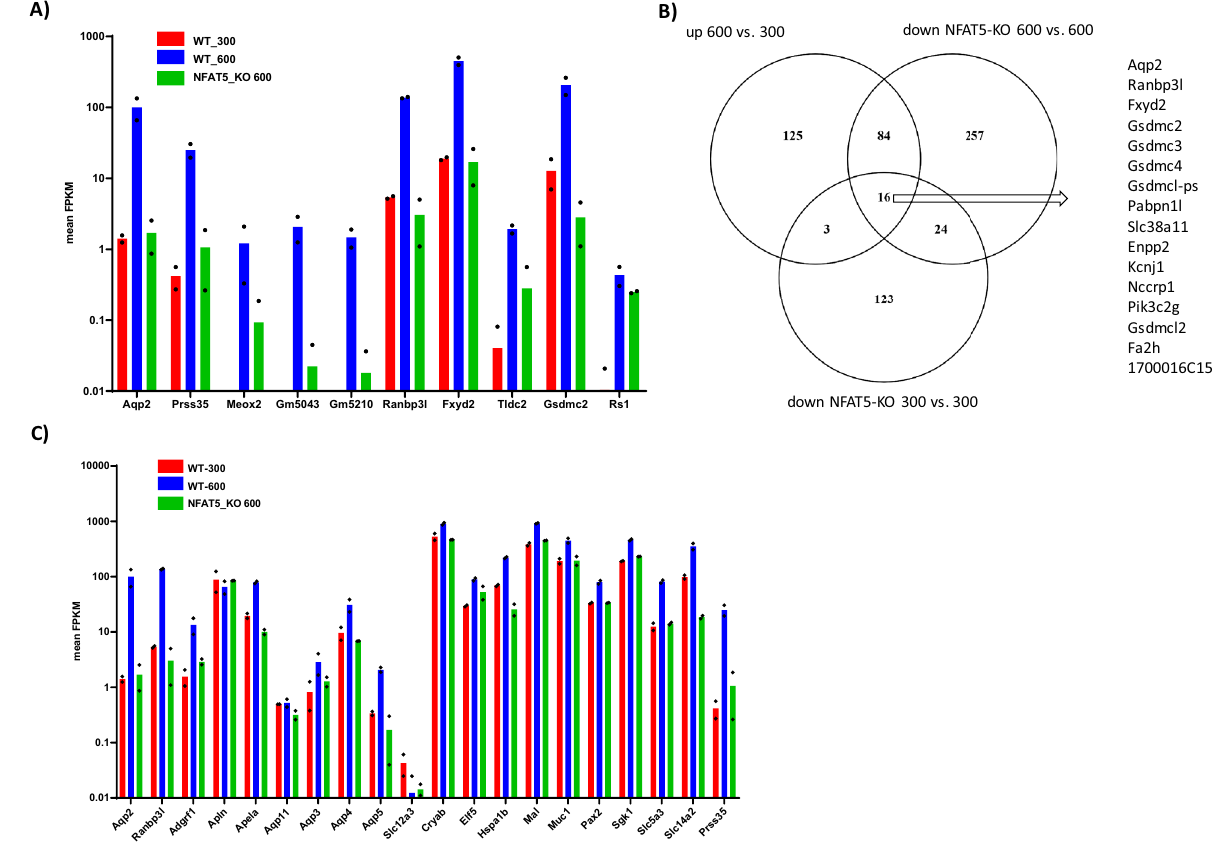
Figure 2. Effect of NFAT5 deletion on top ten hypertonicity induced transcripts. ( A ) Mean FPKM levels of the top ten transcripts that showed the greatest increase under hypertonic (600 mosmol/kg) cell culture compared to control (300 mosmol/kg) conditions in WT IMCD cells. The green bars are showing the mean FPKM level in NFAT5-KO cells cultivated under hypertonic conditions. ( B ) Venn diagram shows common genes up regulated in control cells under hypertonic (600 vs. 300) and down regulated in NFAT5-KO cells under hypertonic (NFAT5-KO 600 vs. 600) and isotonic (NFAT5-KO 300 vs. 300) cell culture conditions. Transcripts with a log2 fold change of at least − 2/2 were included for analysis. The 16 common transcripts are listed on the right side. ( C ) Mean FPKM levels of a set of common hypertonicity induced transcripts and as control of Apln, Aqp11 and Slc12a3 in WT control cells cultivated either at 300 (WT_300) or at 600 (WT_600) mosmol/kg. The green bars show the mean FPKM level in NFAT5-KO cells cultivated under hypertonic cell culture conditions (NFAT5_ KO-600). For all experiments n =